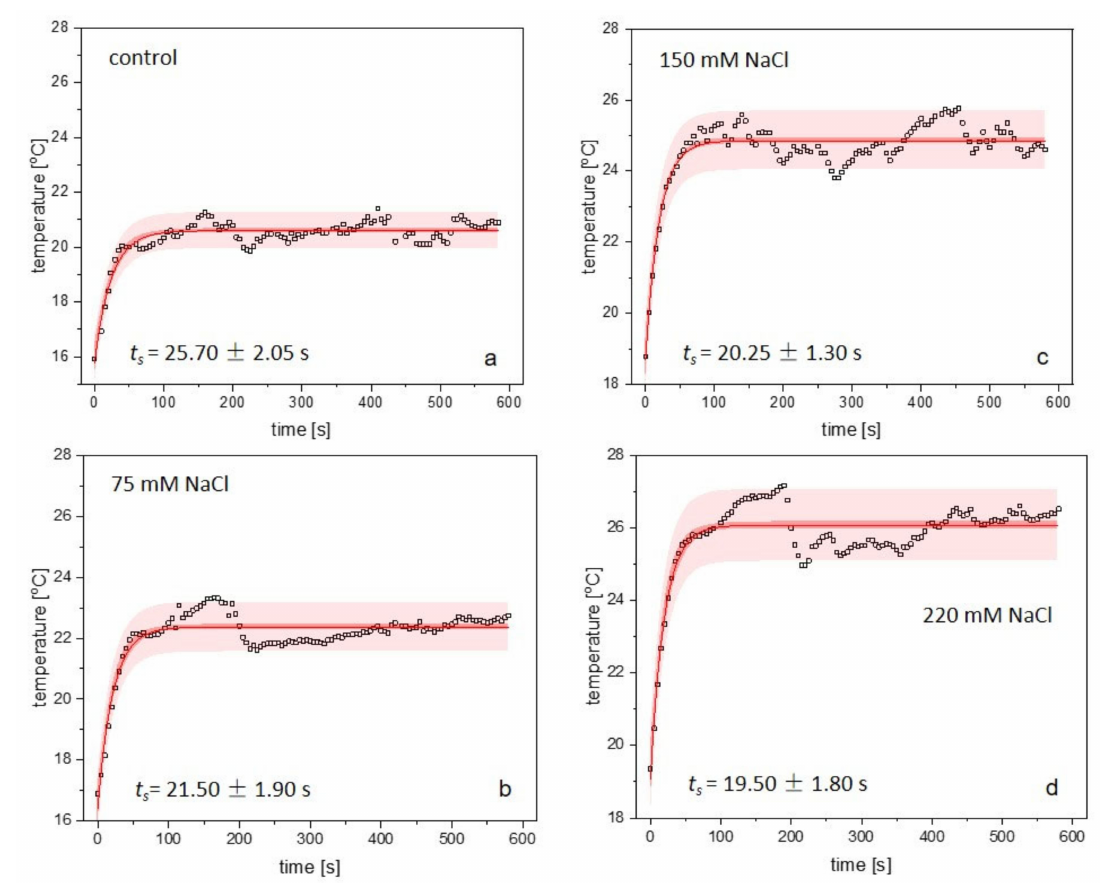
Figure 5. Changes in the temperature of rosette leaves induced by an acute HL treatment measured in A. thaliana plants exposed to salinity. Each point on the graph represents the mean value of at least three randomly chosen spots on the thermal image for control ( a ), 75 ( b ), 150 ( c ), and 220 mM ( d ) NaCl treatments. The thermal kinetics were fitted using a mono-exponential function, y = y 0 + y s · [1 − exp( − t/t s )]. Theoretically determined courses approximate the initial responses of plants to excess light three days after exposure to salinity. Each graph ( a – d ) shows the fitted thermal data along with 95% prediction ( light red surfaces ) and confidence ( dark red surfaces ) bands. The light intensity was 2000 µ mol · m − 2 · s − 1 .